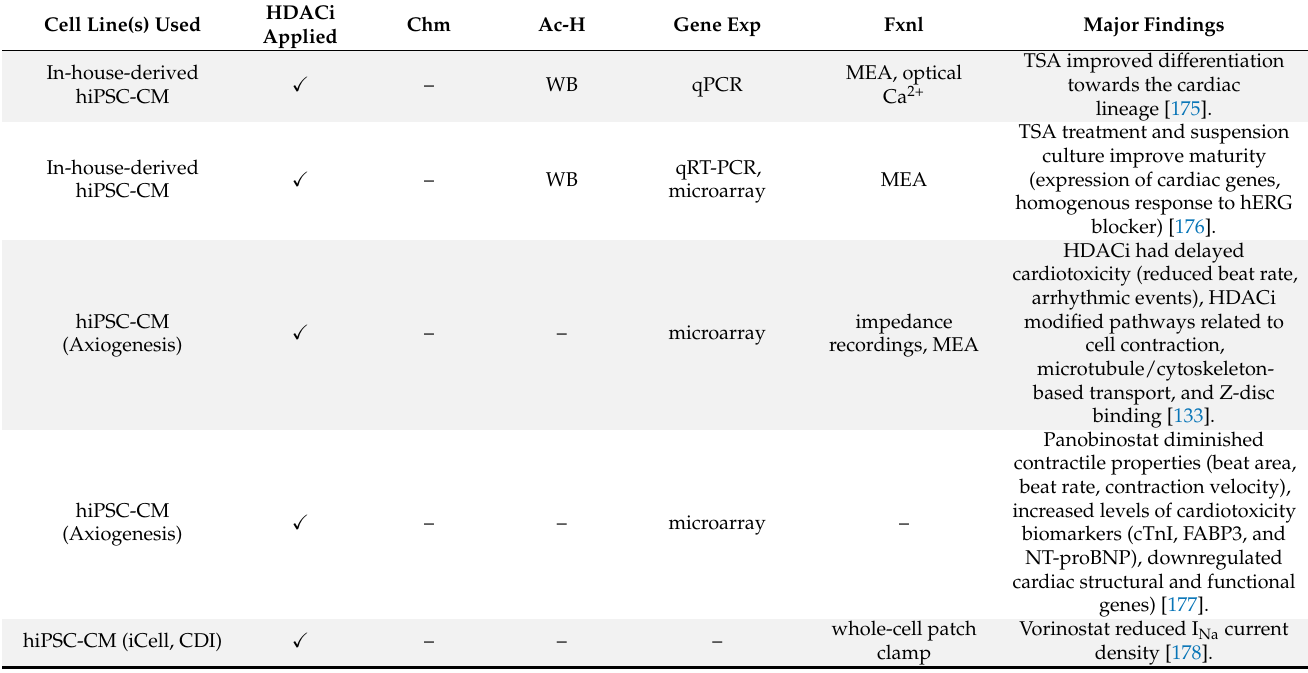
Table 4. Previous epigenetics studies of hiPSC-CMs. Chm indicates chromatin accessibility assay, ac-H indicates histone acetylation assay, gene exp indicates gene expression quantification, and Fxnl indicates functional behavior measurements. “ (cid:88) ” indicates a study’s experimental use of HDAC